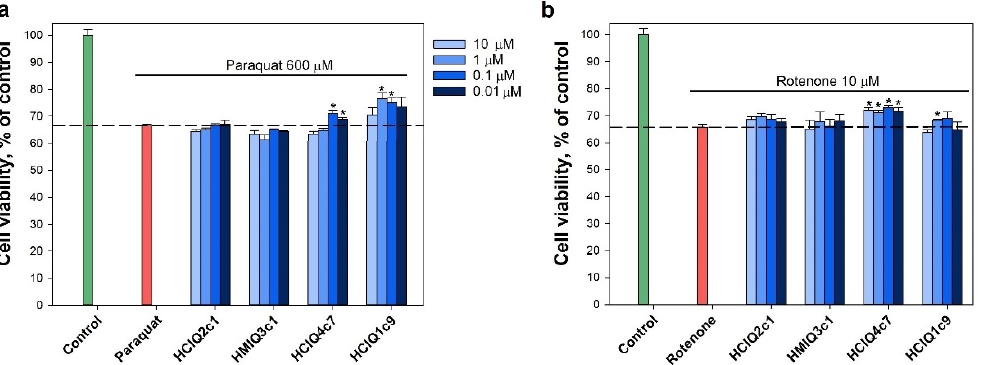
Figure 7. Effects of the peptides on neuroblastoma cell viability in the presence of 600 µM paraquat ( a ) and 10 µM rotenone ( b ). The data are shown as means ± SE; * — p < 0.05.